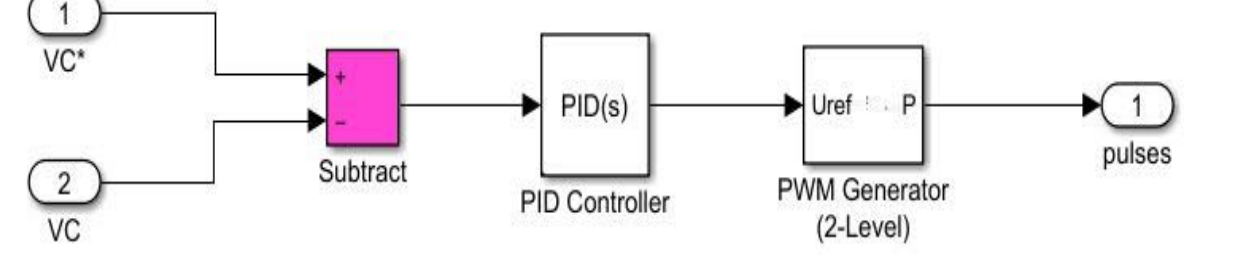
Figure 8. PWM with PI controller technique for pulsing.